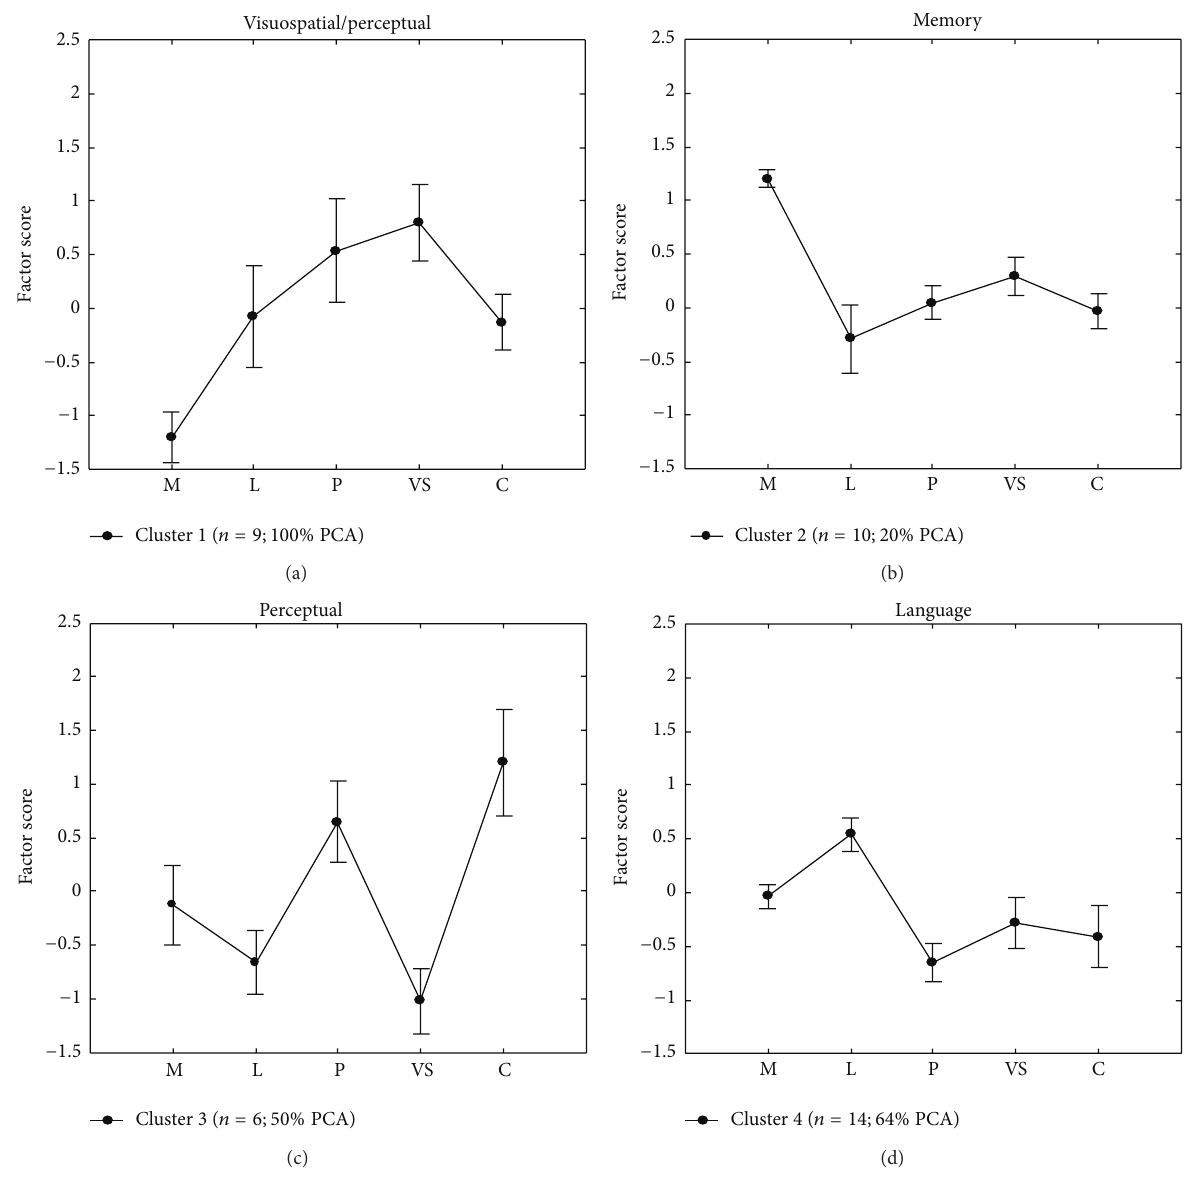
Figure 2: Plots (a)–(d) illustrate cluster 1–4. Mean factor scores and standard errors obtained by clusters, as a function of the factors extracted by the principal component analysis, are reported (M: memory, L: language, P: perceptual, VS: visuospatial/perceptual, C: calculation). High scores indicate lower performance. Each cluster number of patients and percentage of PCA are also